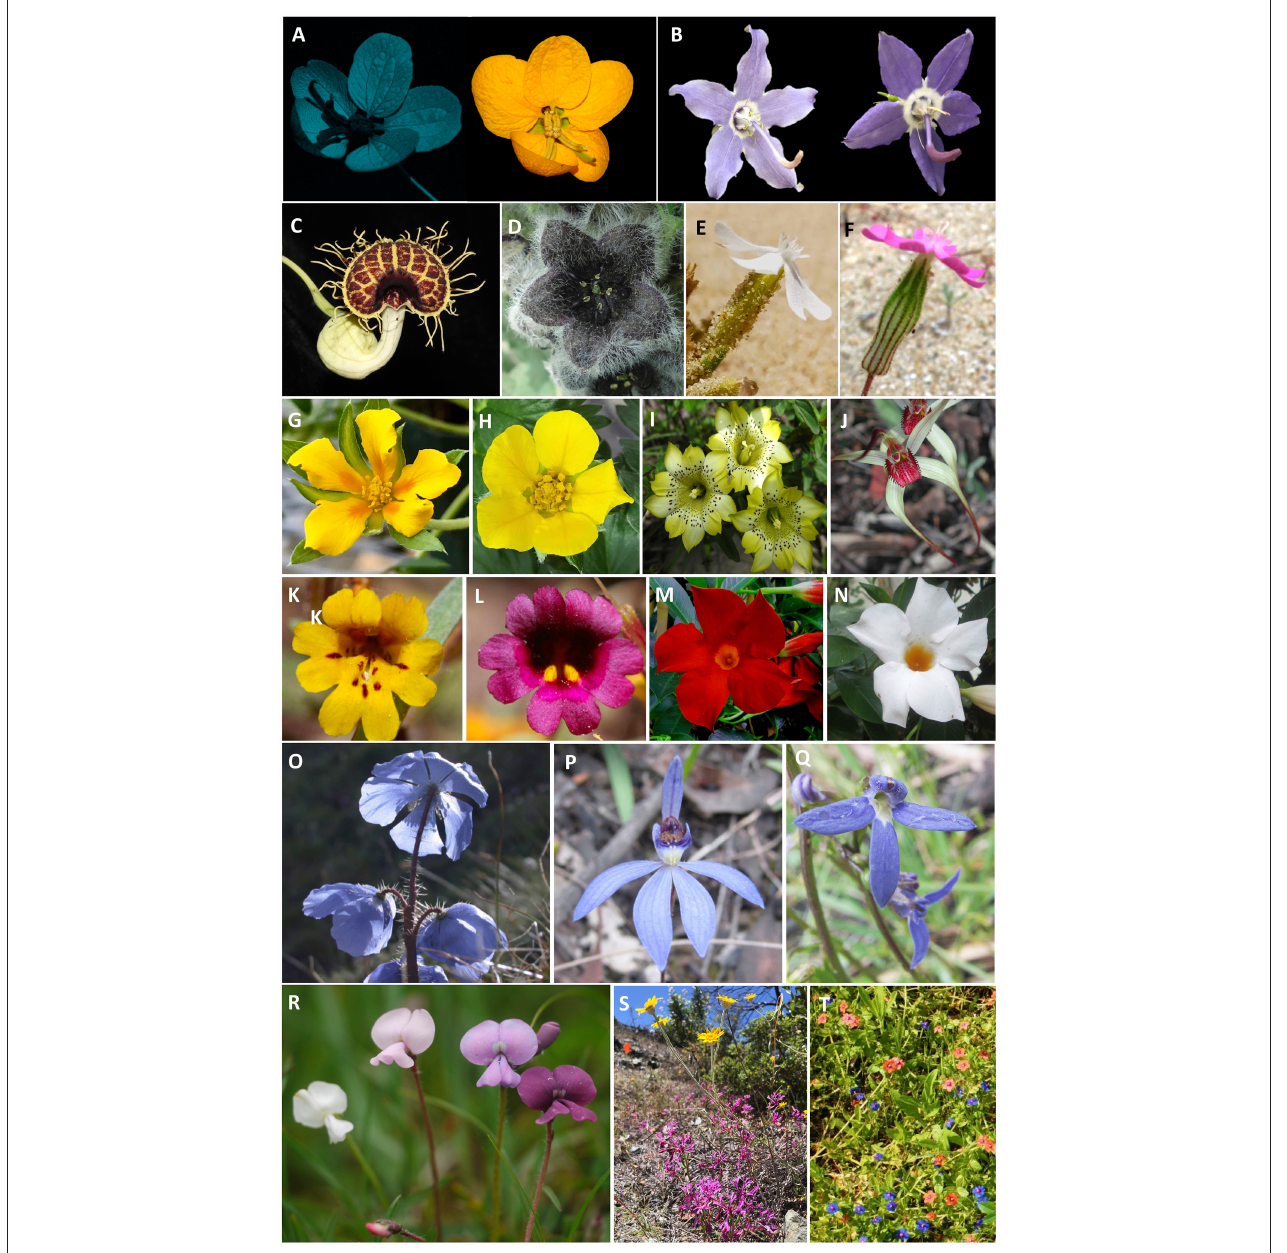
FIGURE 1 | Examples of species included in our Research Topic “ The Role of Flower Color in Angiosperm Evolution .” (A) Senna rugosa (Fabaceae) using UV (left) and conventional photography (right) (Brazil, Mariah di Stasi). (B) Flower color variation in Campanula americana (Campanulaceae, USA, Matthew Koski). (C) Aristolochia fimbriata (Aristolochiaceae, Colombia, Natalia Pabón-Mora). (D) Jaborosa rotacea (Gesneriaceae, Argentina, Marcela Moré). (E,F) White and pink flowers of Silene littorea plants (Caryophyllaceae, Spain, Eduardo Narbona). (G,H) Potentilla plattensis and Argentina anserine (Rosaceae, USA, Matthew Koski). (I) Gentiana flavomaculata (Gentianaceae, Taiwan, Chun-Neng Wang). (J) Caladenia fulva (Orchidadeae, Australia, Ann Lawrie). (K,L) Flower color morphs of Erythranthe discolor (Phrymaceae, USA, Naomi Fraga and Dena Grossenbacher). (M,N) Flower color morphs of Mandevilla sanderi (Apocynaceae, The Netherlands, Doekele Stavenga). (O) Meconopsis horridula (Papaveraceae, China, Anke Jenstsch). (P) Caladenia caerula (Orchidaceae, Australia, Mani Shrestha). (Q) Lobelia rhombifolia (Campanulaceae, Australia, Mani Shrestha). (R) Flower color variation in Tibetia yunnanensis (Leguminosae, China, Klaus Lunau). (S) Plants of Eriophyllum lanatum (Asteraceae) and Clarkia concinna (Onagraceae) coexisting (USA, Gerardo Arceo-Gómez). (T) Flower color morphs of Lysimachia arvensis coexisting (Primulaceae, Spain, Montserrat Arista).